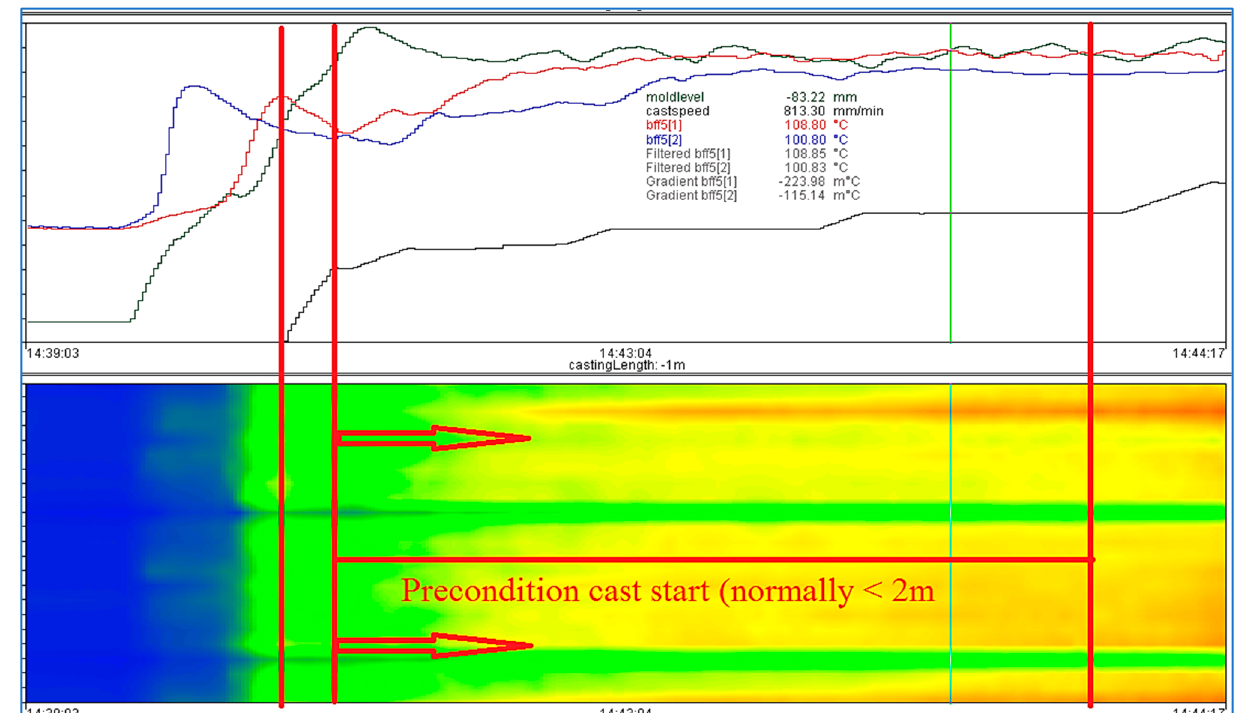
Figure 11. Start cast alarm during unstable casting condition.